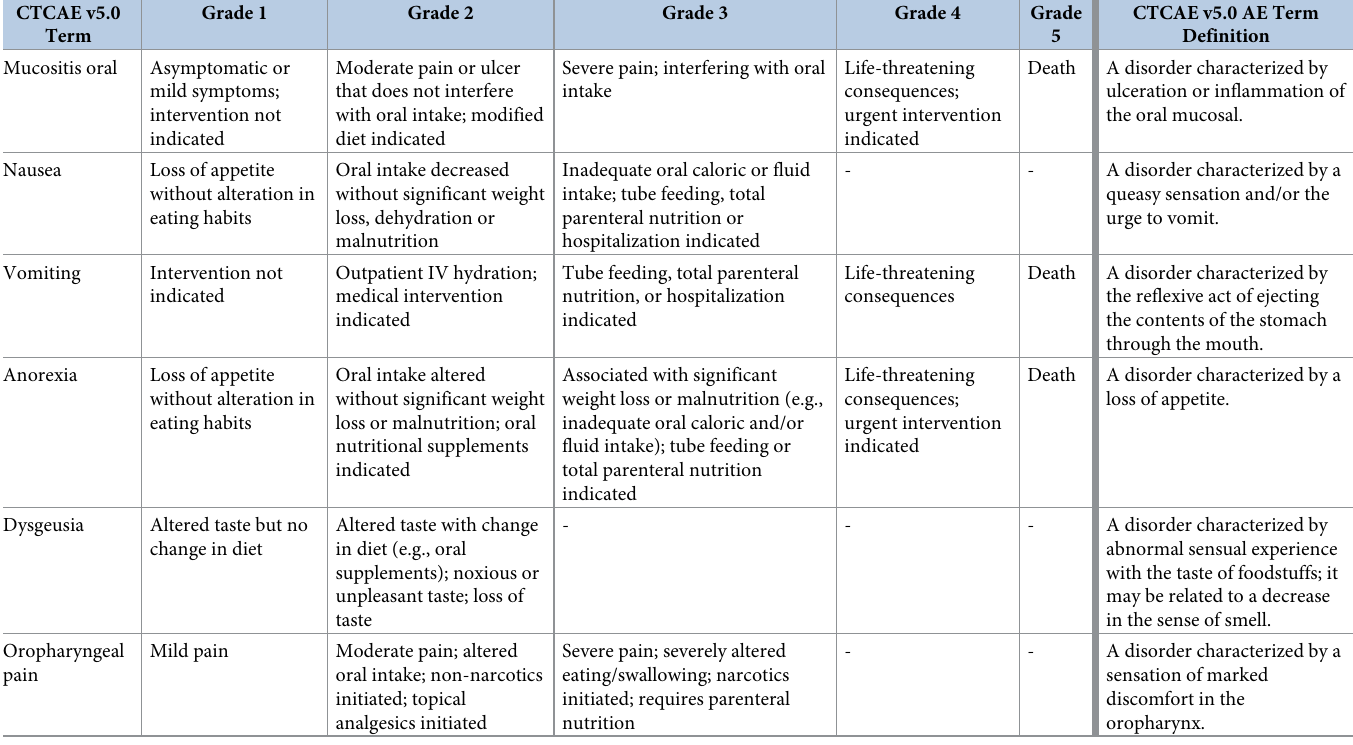
Table 1. Nutrition-related adverse events according to the CTCAE and